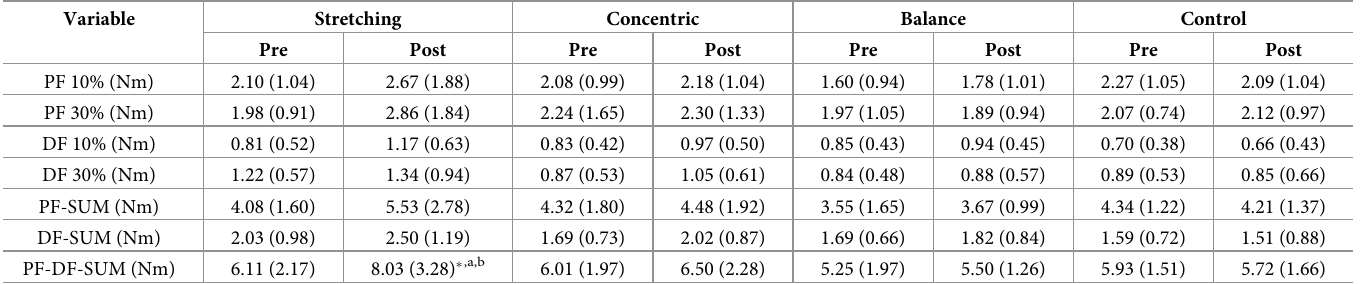
Table 2. Comparison of the error scores for force sense between different exercise modalities. Variable Stretching